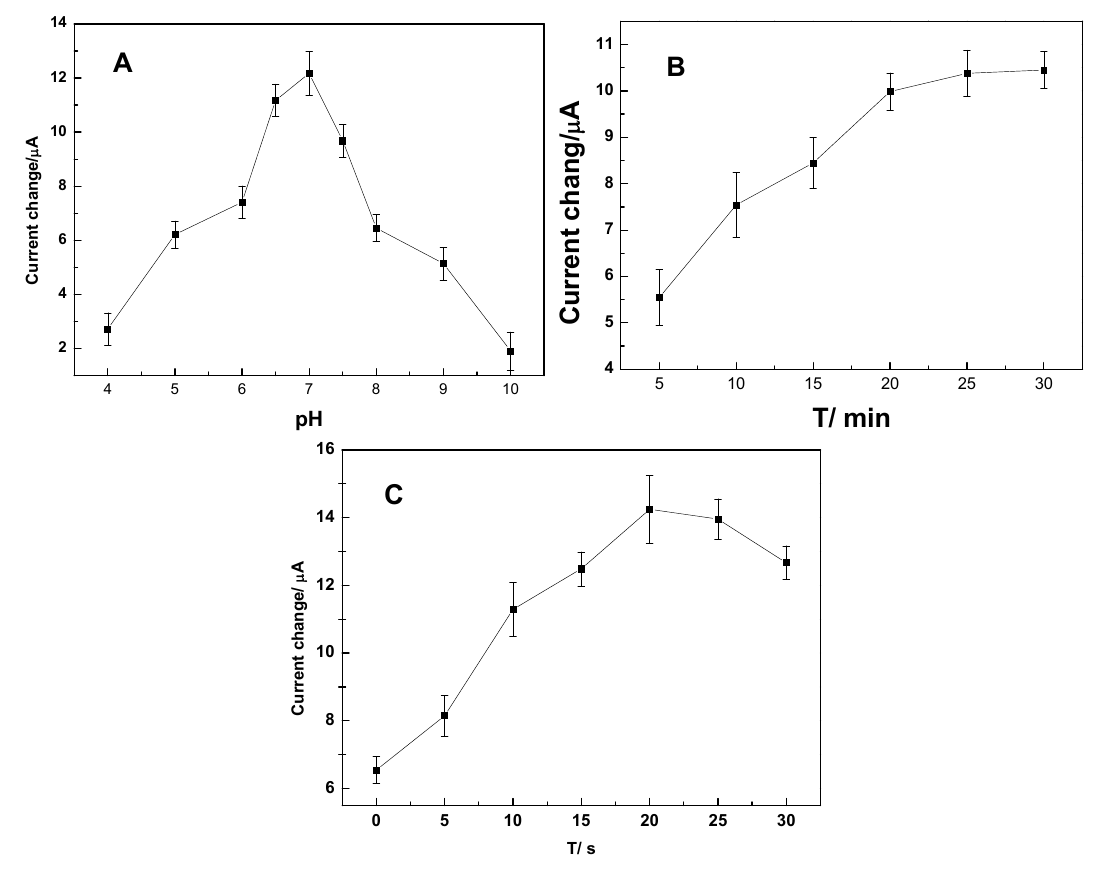
Figure 5. Effects of pH ( A ), incubation time ( B ), and electroplating time ( C ) on the response of the